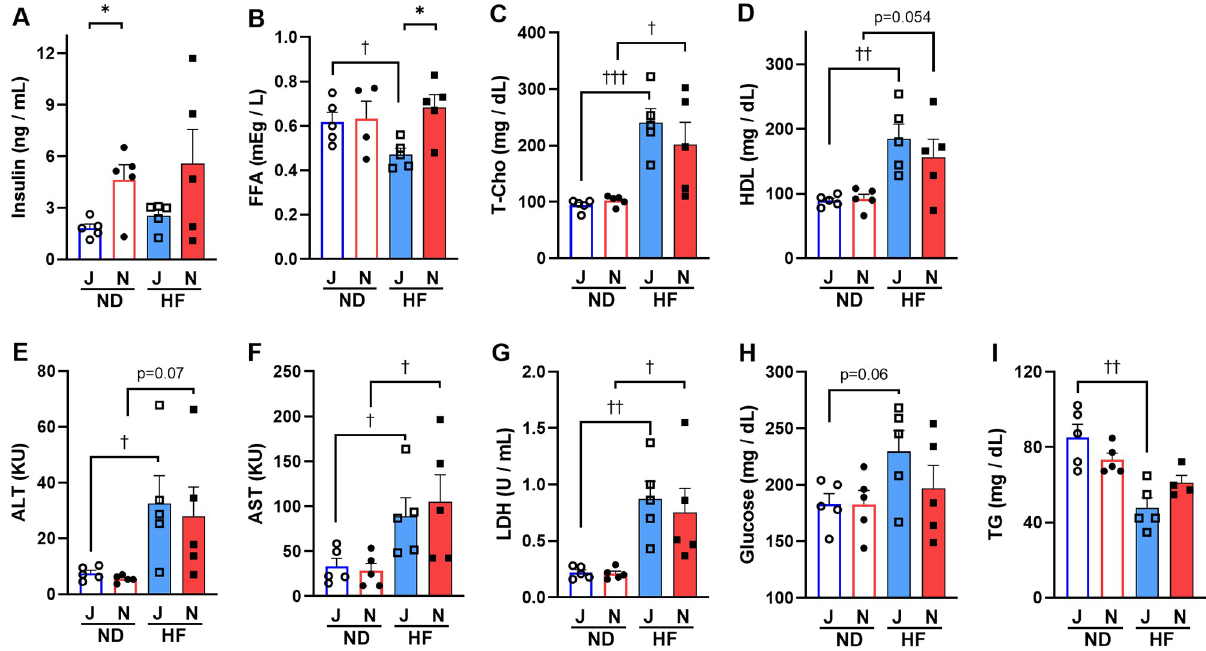
Fig 4. Differences in metabolic parameters in the plasma of B6J and B6N mice on ND or HF. (A) Insulin, (B) FFA, non-esterified fatty acids:, (C) T-Cho, total cholesterol;, (D) HDL, high-density lipoprotein cholesterol;, (E) ALT, alanine aminotransferase;, (F) AST, aspartate aminotransferase;, (G) LDH, lactate dehydrogenase;, (H) Glucose, and (I) TG, triglyceride. Bars are representative of means + SEM (n = 5), for B6J group (blue color) and B6N group (red color). Two-way ANOVA indicated a significant interaction between substrain and diet for TG ( p < 0.05; F = 5.89; Df = 15). There was a significant effect of strain on insulin ( p < 0.05; F = 6.87; Df = 16) and FFA ( p < 0.05; F = 4.67; Df = 15) independent of diet, and a significant effect of diet on T-Cho ( p < 0.0001; F = 27.50; Df = 16), HDL ( p < 0.001; F = 18.66; Df = 16), ALT ( p < 0.01; F = 11.83; Df = 16), AST ( p < 0.01; F = 10.74; Df = 16), LDH ( p < 0.001; F = 19.75; Df = 16), and TG ( p < 0.001; F = 22.85; Df = 15) independent of strain. Individual means were compared within groups using unpaired Student’s t -test. Asterisks ( � ) and daggers (†) indicate significant differences between B6J and B6N substrain groups and ND and HF diet groups, respectively ( � p < 0.05, † p < 0.05, †† p < 0.01, and ††† p < 0.001). J, B6J substrain; N, B6N substrain; ND, normal diet, HF, high-fat diet; open circles, ND-fed B6J; filled circles, ND-fed B6N; open squares, HF-fed B6J; filled squares, HF-fed B6N.